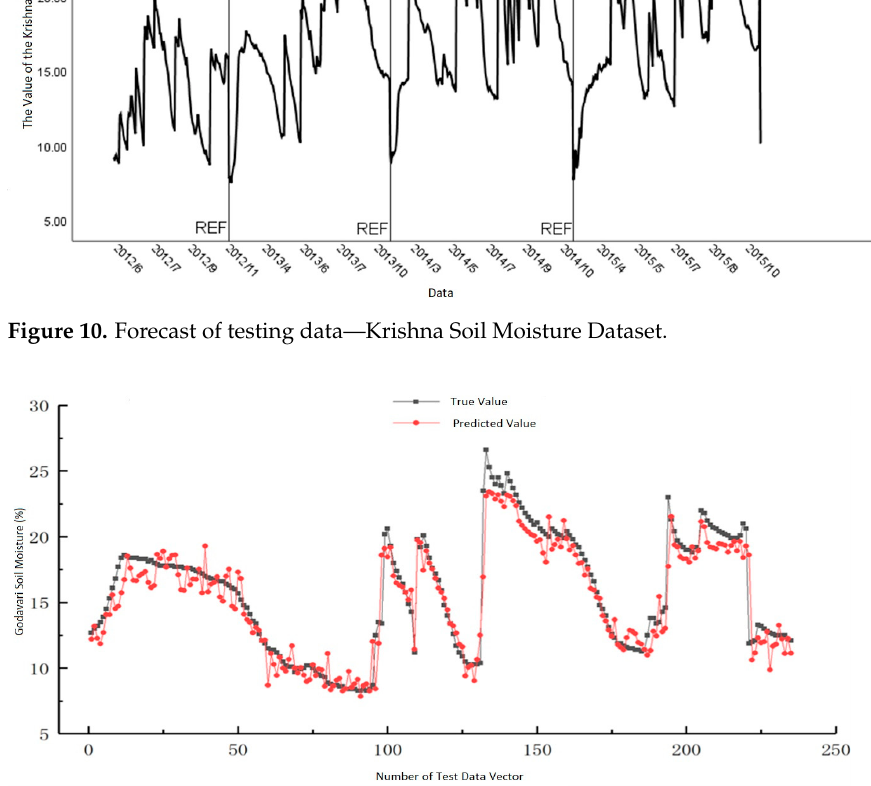
Figure 11. Future forecast of testing data—Godavari Soil Moisture Dataset.